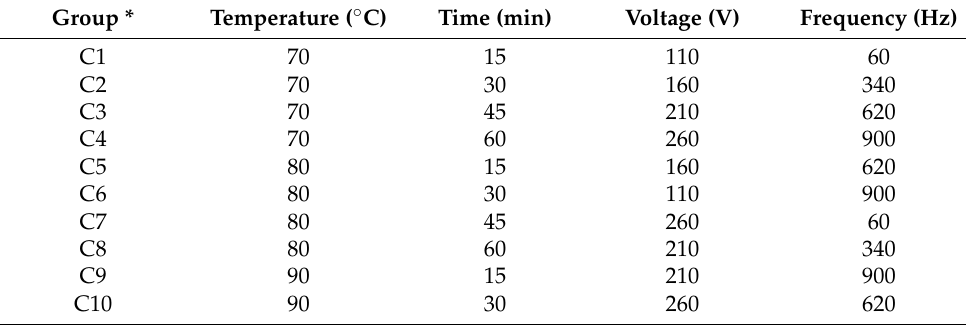
Table 1. The various experimental conditions as designed by the Taguchi